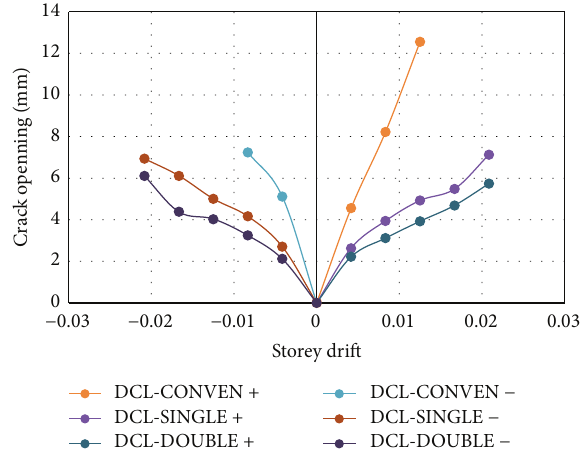
Figure 19: Crack opening curves for the DCL group in the critical zone for both loading directions, positive and negative for the DCL